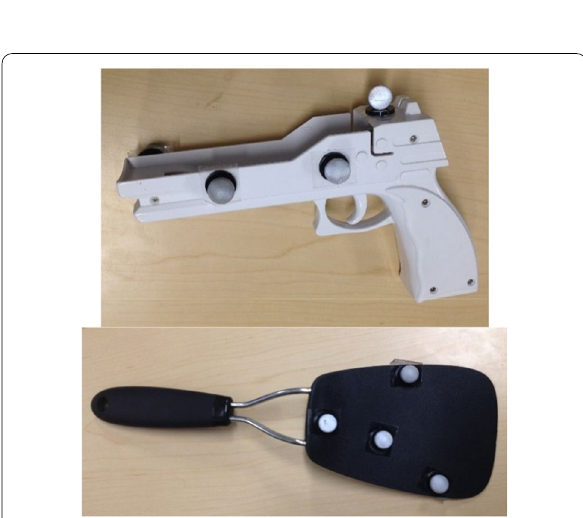
Fig. 2 Objects held during the experiment. The markers were affixed to the objects to track the participants’ movements